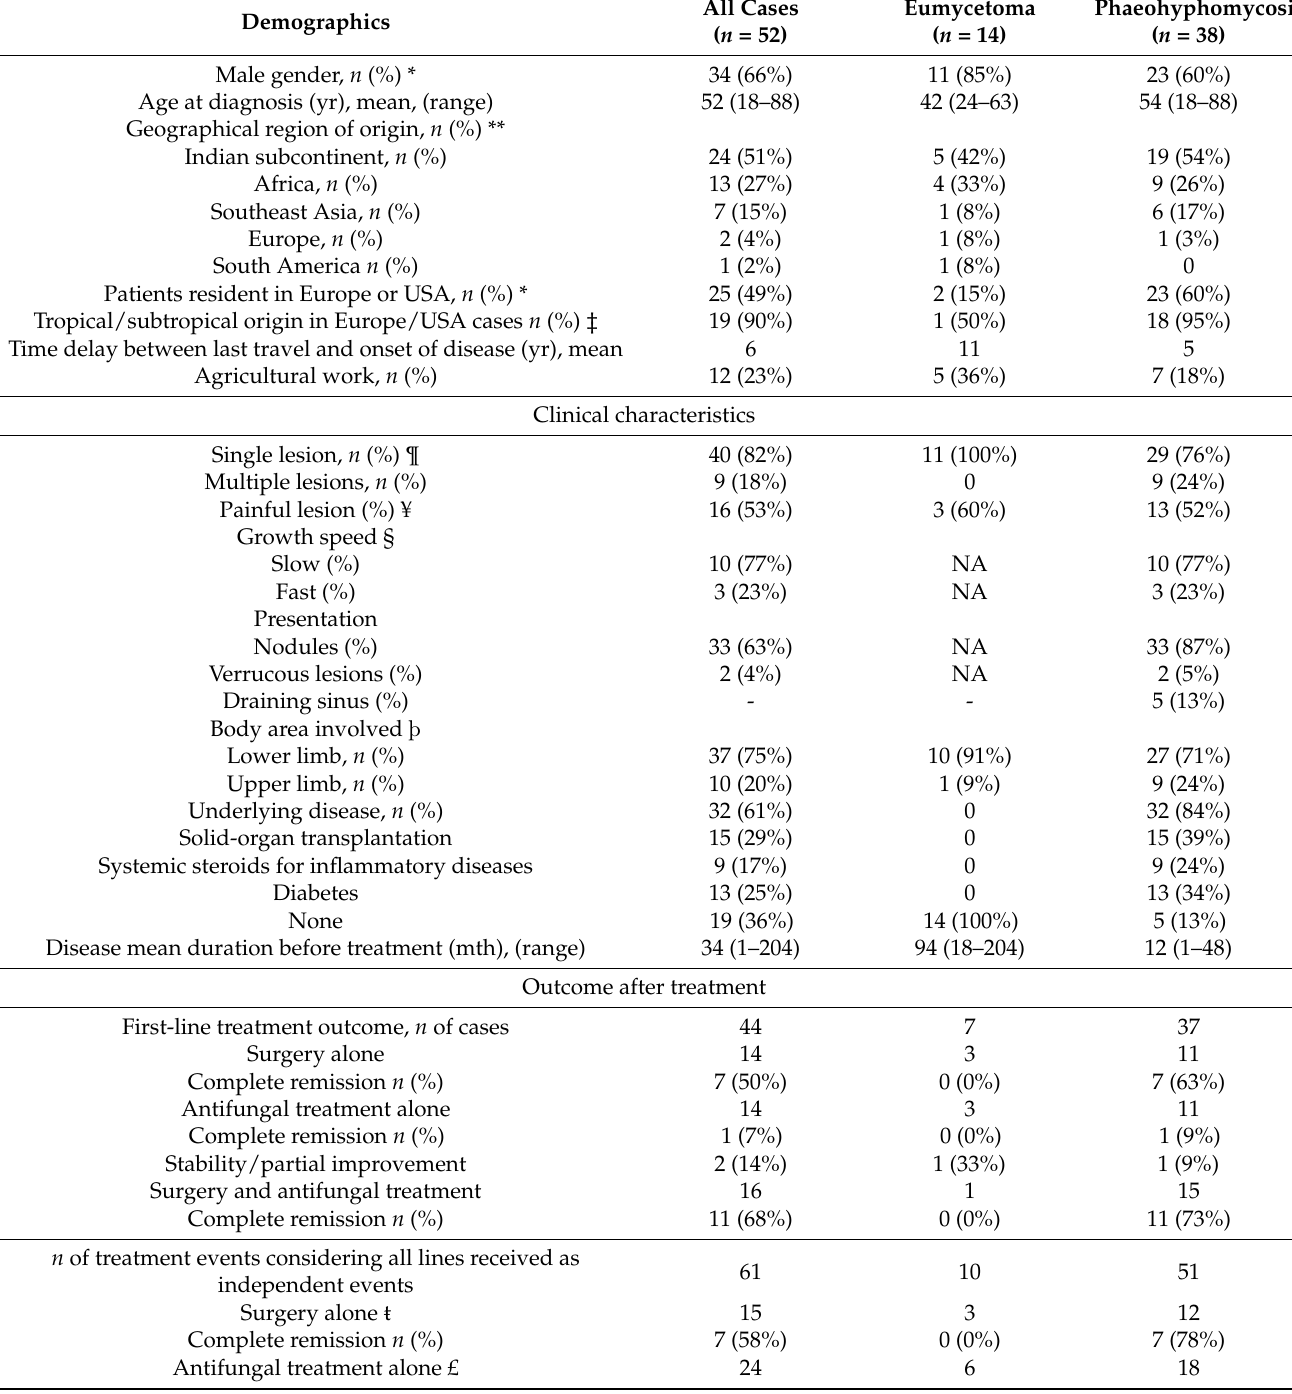
Table 3. Demographics, clinical characteristics, and outcome in patients with phaeohyphomycosis and eumycetoma caused by M. romeroi